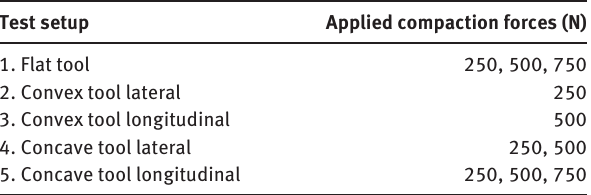
Figure 6 Five different test scenarios with three tool designs for static roller tests. Table 2 Test setup with applied compaction forces.